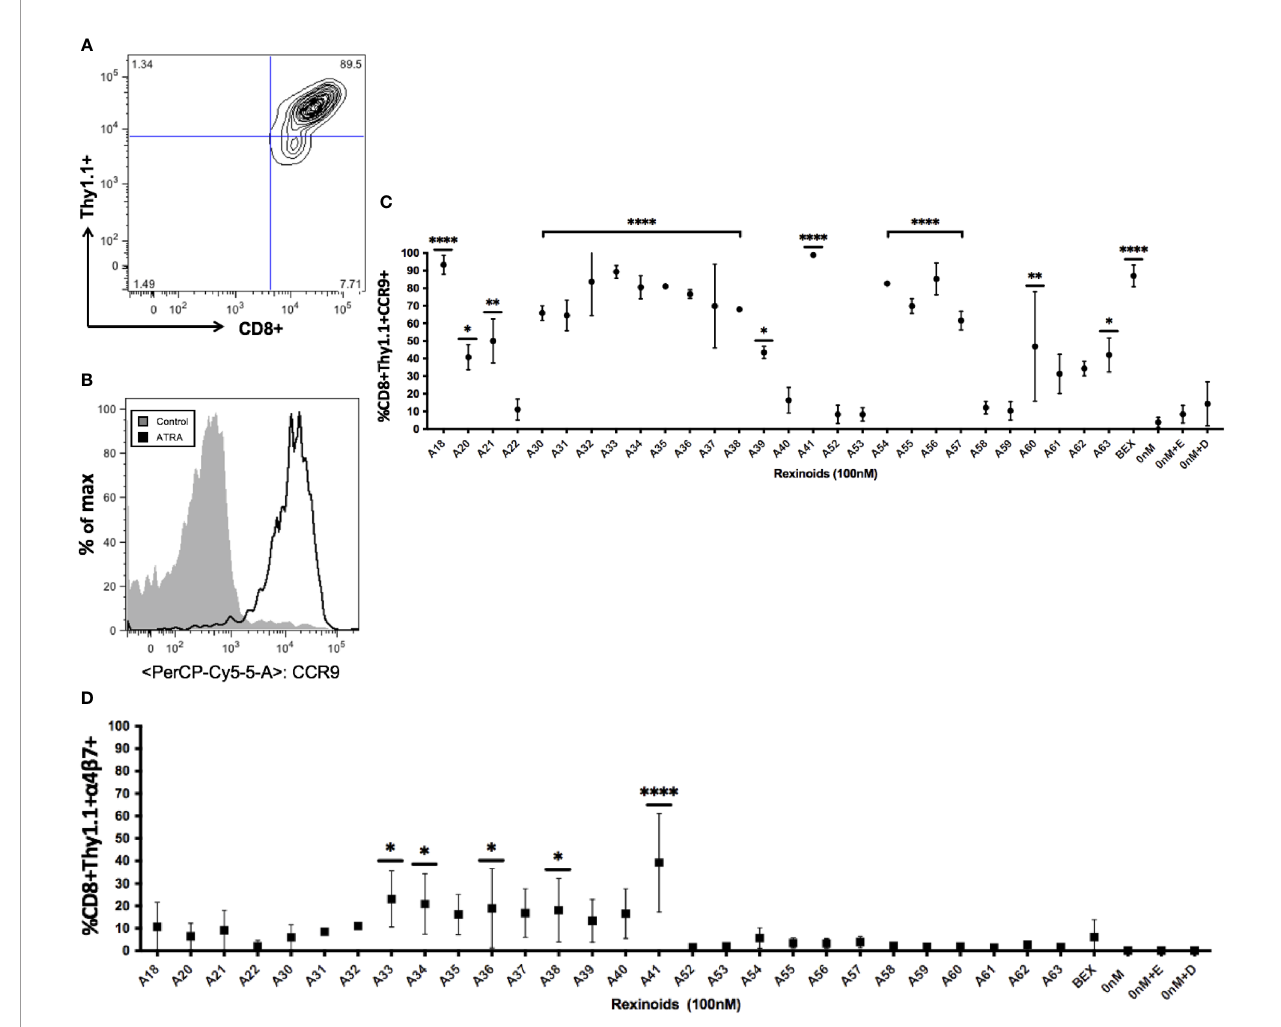
FIGURE 2 | Rexinoid treatment enhances CCR9 and a 4 b 7 expression on effector CD8+ T cells in vitro . Splenocytes obtained from a naïve P14 mouse were stimulated with GP 33-41 peptide and cultured for 8 days with a large panel of novel rexinoids delivered at a 100nM concentration (treatment every 48 hours). Cells were then analyzed for changes in expression of CCR9 and a 4 b 7. Analysis was performed using fl ow cytometry. (A) Antigen-speci fi c effector CD8+ T cells gated using appropriate markers. (B) CCR9 expression is upregulated on antigen-speci fi c effector CD8+ T cells following ATRA treatment given over an 8 day time course. (C) shows % positive CCR9 expression on antigen-speci fi c effector CD8+ T cells following 8 day rexinoid treatment. Experiment performed in triplicate. (D) a 4 b 7 expression on antigen-speci fi c effector CD8+ T cells following 8 day rexinoid treatment. Experiment performed in duplicate. Connecting letters report used to determine statistical signi fi cance, with ordered differences report used to compare p-values between groups (* = p < 0.05, ** = p < 0.005, **** = p < 0.0001). All error bars represent SD from the